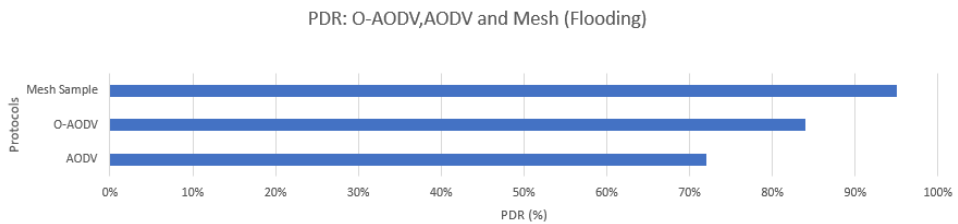
Figure 18. Overhead: O-AODV, AODV, and mesh (flooding).